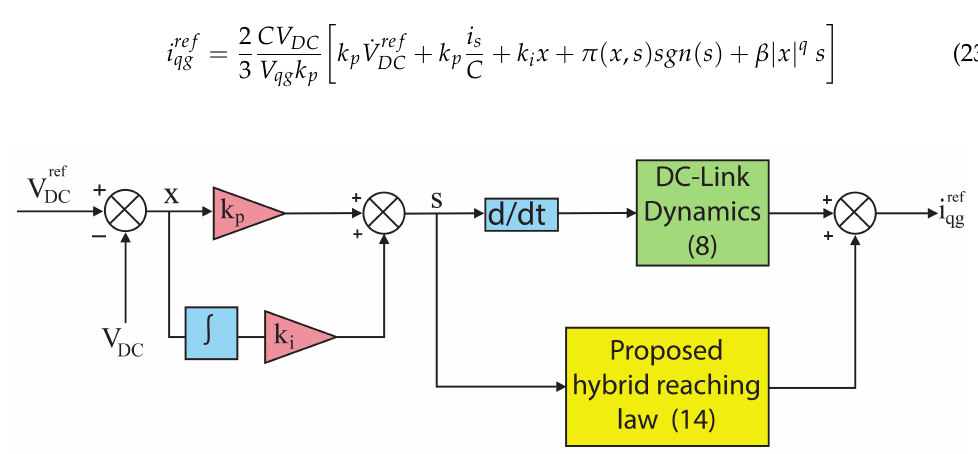
Figure 3. DC-link voltage controller design using the proposed SMC-HRL